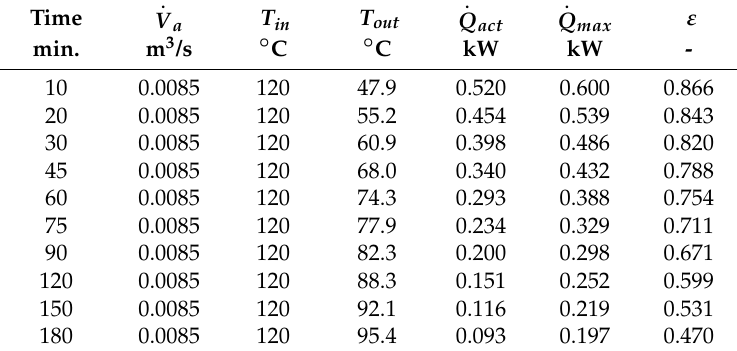
Table 5. Measured values and calculations for experiment No. 9.